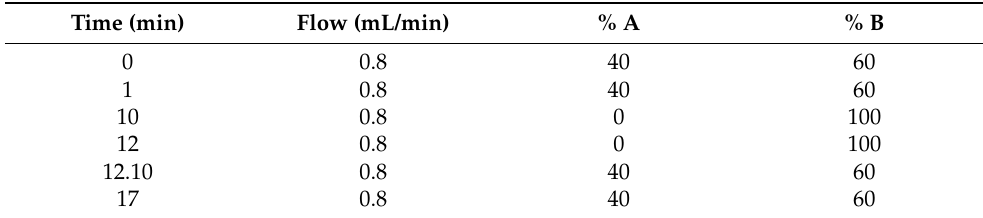
Table 1. Chromatographic gradient used for analysis by LC-MS/MS. Phase A: 0.1% formic acid in water; phase B: